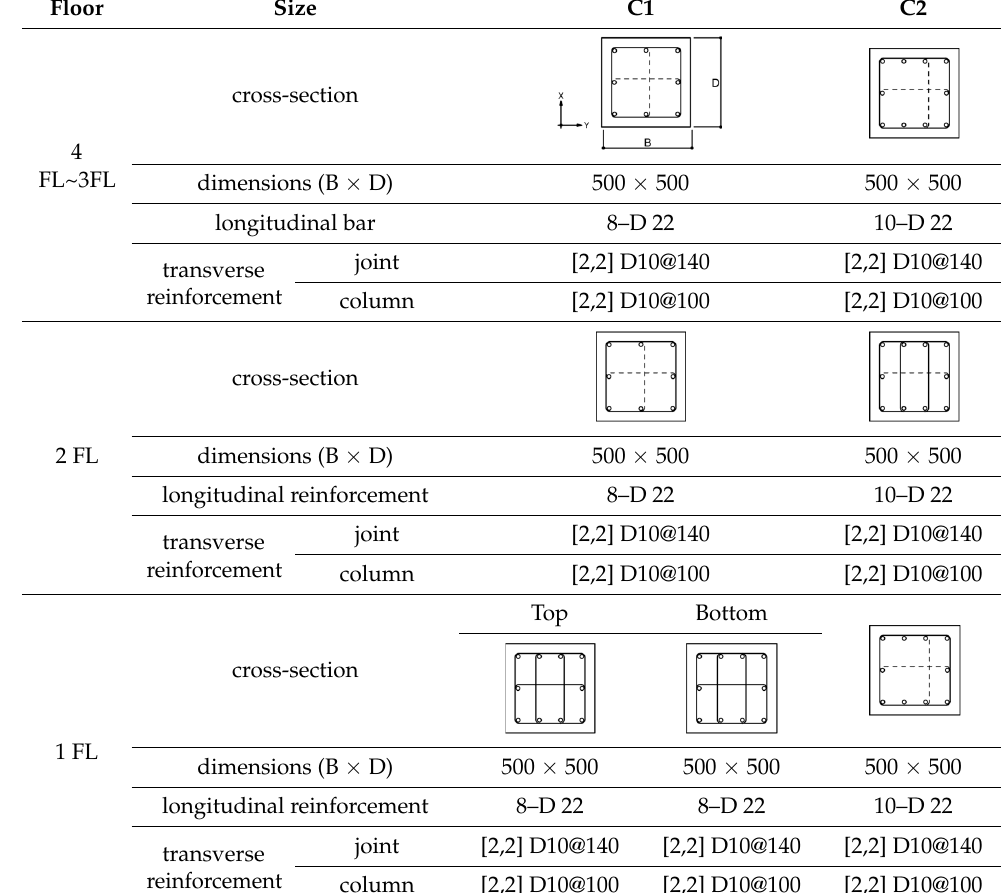
Table 2. Cross-sections and reinforcement details of columns.